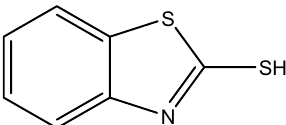
Figure 1. Structure of 2-mercaptobenzothiazole